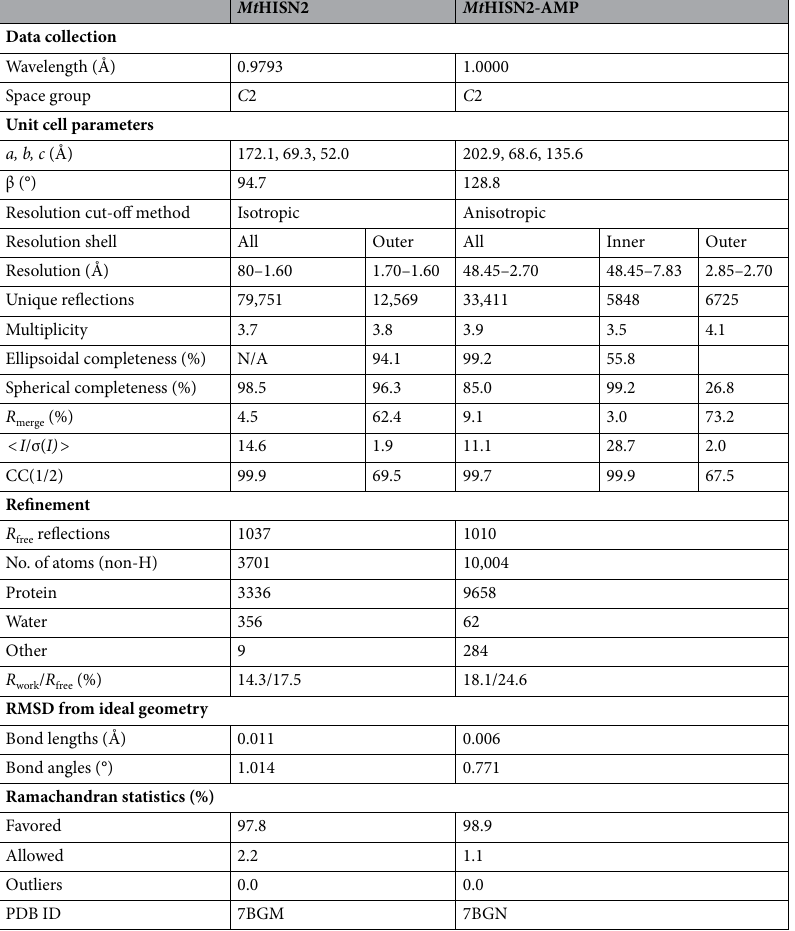
Table 1. Diffraction data and refinement